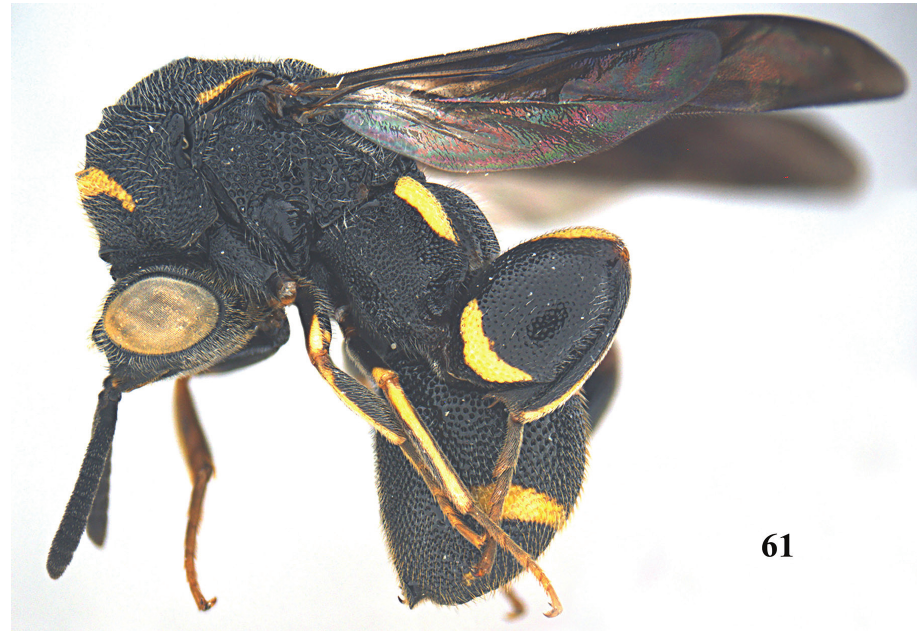
Figure 61. Leucospis femoricincta Bouček, ♂ from Guangdong, Yingxifenglin, habitus lateral. Colouration . Head black (Figs 57, 58). Antenna black, with scape partly yellow ventrally (Figs 53, 57). Pronotum with one yellow arcuate band at discal carina, not reaching anterior corners (Figs 54, 55). Mesoscutum black, with elongate yellow patch laterally (Fig. 55). Mesoscutellum black, with short U-shaped yellow mark posteriorly (Fig. 55). Dorsellum and propodeum black. Mesopleuron and metapleuron black. Wings brownish. Hind coxa black, with yellow patch baso-dorsally (Fig. 59). Hind fe- mur with lunate yellow mark subbasally, and yellow elongate patch dorsally (Fig. 60). Metasoma black, T1 with two medium-sized yellow spots laterad of ovipositorial fur- row, T4 with narrow yellow transverse band, T5 with broad yellow transverse band (Fig. 56). Epipygium